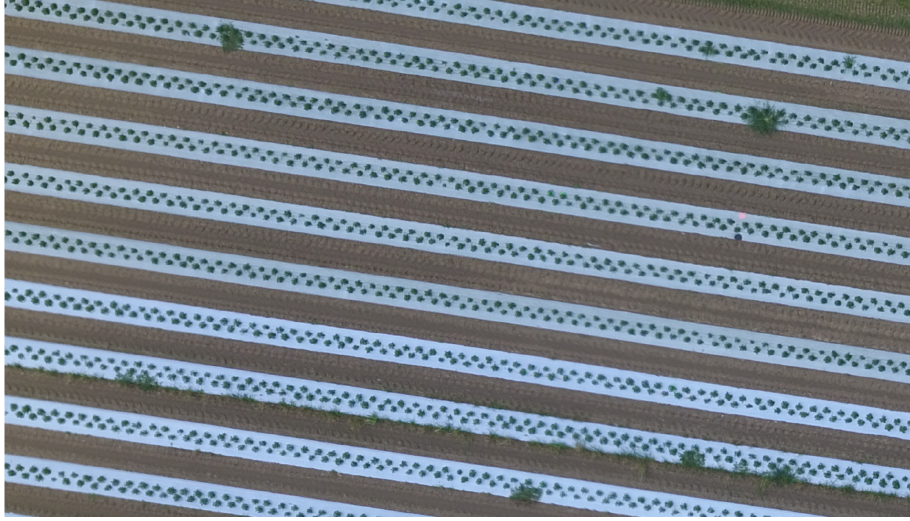
Figure 3. RGB image of a part of the Chilli field